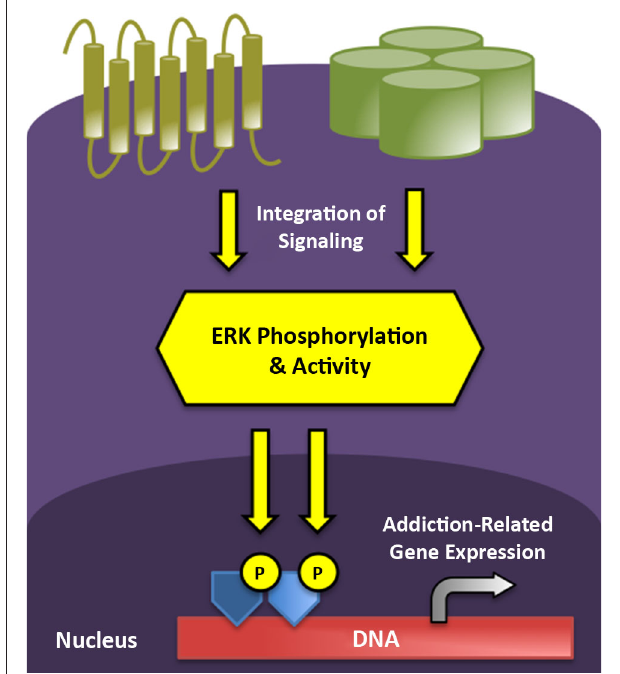
FIGURE 1 | ERK phosphorylation integrates and impacts multiple levels of intracellular signaling to mediate short- and long-term neuroplasticity associated with the transition to addicted states . G protein-coupled receptors (gold) and ion channels (green) represent two major receptor classes that modify ERK phosphorylation in stress and reward circuitry following neurotransmitter binding. Active ERK can translocate to the nucleus to drive addiction-related patterns of gene expression following the subsequent phosphorylation of transcription factors (dark blue) and core histones (light